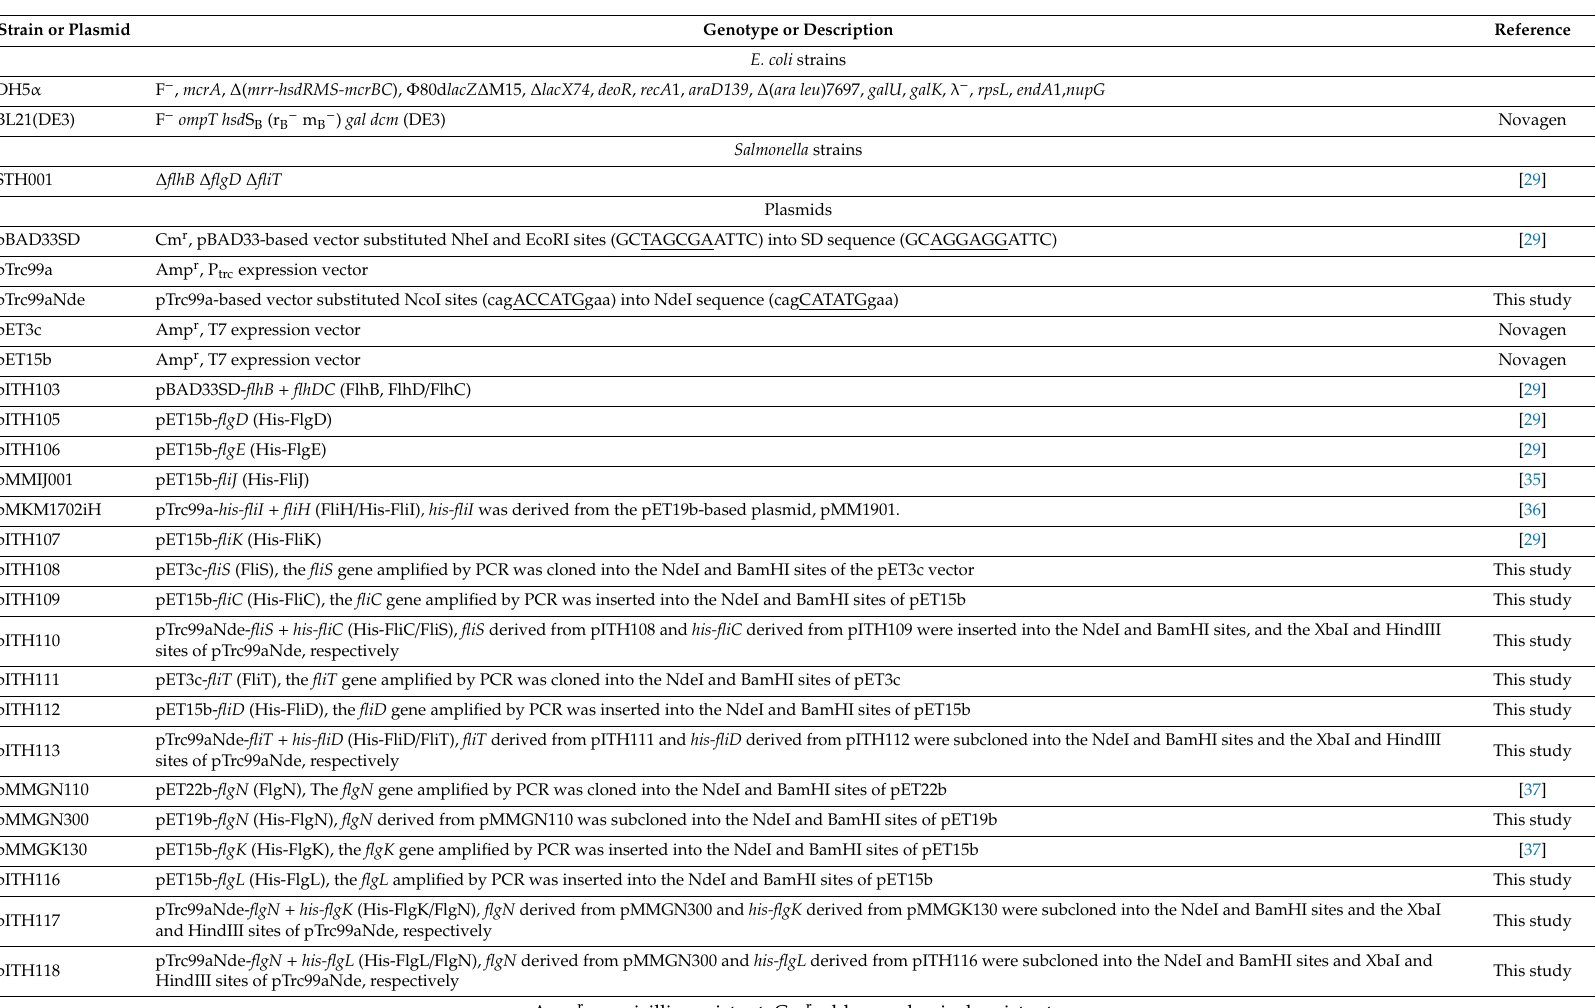
Table 1. Bacterial strains and